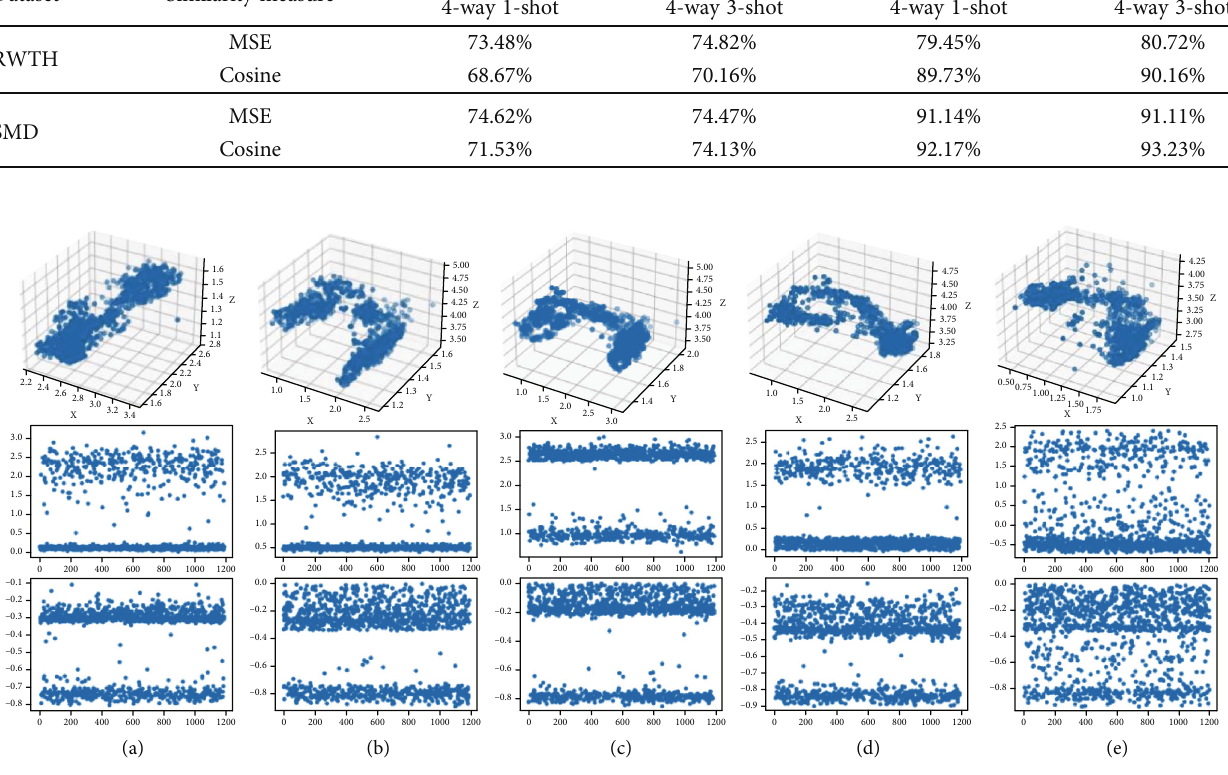
Figure 8: E ff ects of di ff erent dimensionality reduction methods on feature